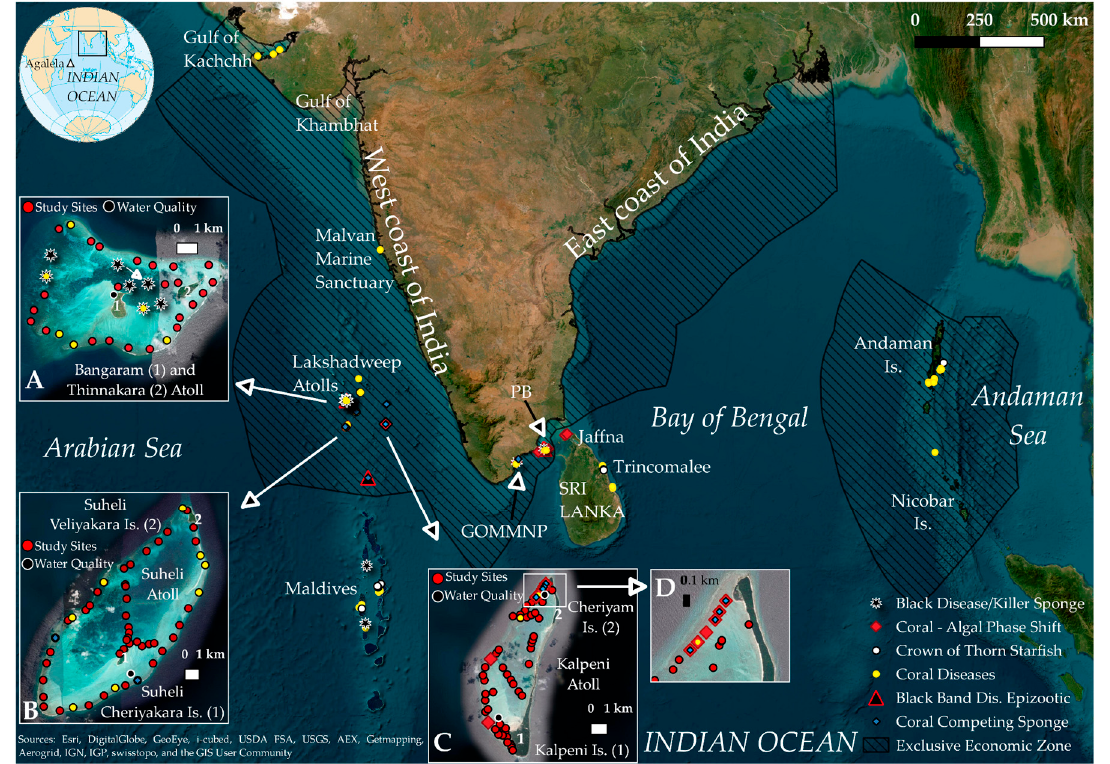
Figure 1. The Indian Exclusive Economic Zone (EEZ) indicates the current study locations and studies pertaining to different aspects of coral diseases, coral competing sponges (CCS), and coral–algal phase shift within the EEZ and contiguous international waters. ( A ) Sites at Bangaram and Thinnakara Atoll; adapted and updated from [21], white arrow, a previously unreported BD site. ( B ) Sites at Suheli Atoll. ( C ) Sites at Kalpeni Atoll. ( D ) Zoomed on the location of reefs near Cheriyam Is. (Kalpeni Atoll) [GOMMNP: Gulf of Mannar Marine National Park; PB: Palk Bay; black disease = T . hoshinota )]. Globe top-left: https://www.worldatlas.com/aatlas/infopage/oceans/indian.gif (Accessed on 6th December 2022).